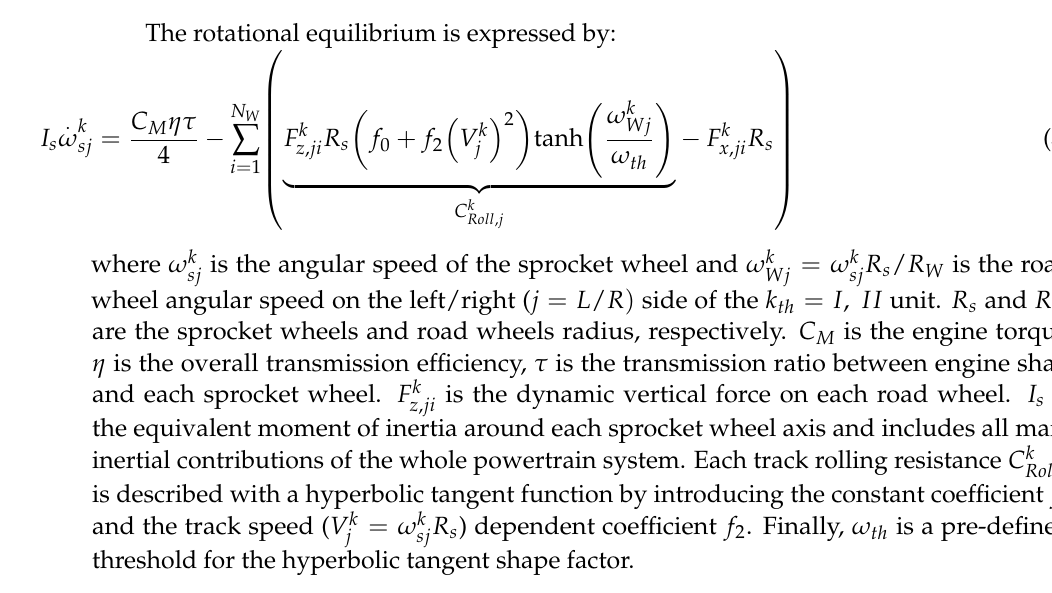
Figure 3. Free body diagram of each track rotational dynamics.